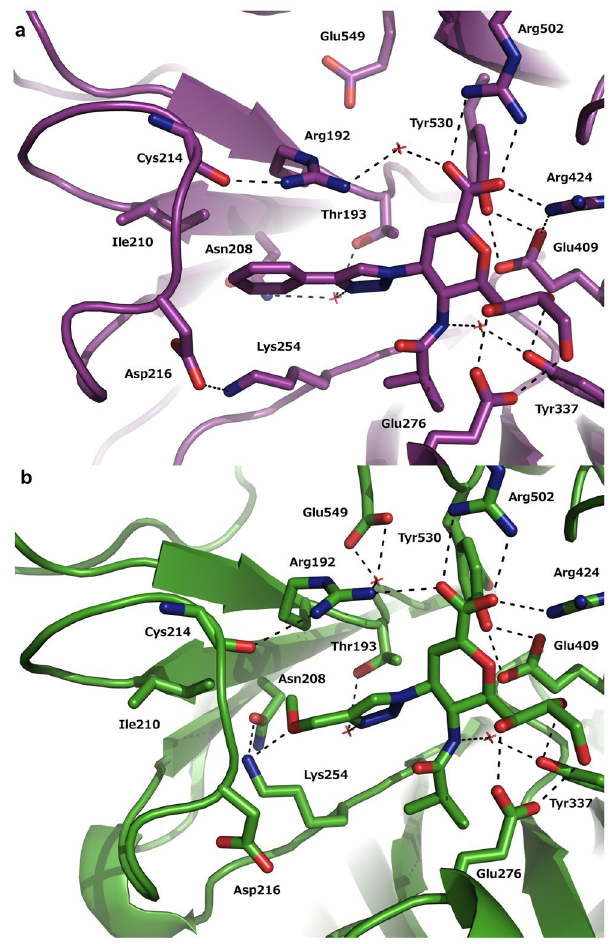
Figure 3. hPIV-3 HN– 5 and – 6 complexes. hPIV-3 HN active site complexed with inhibitor 5 (top) and with inhibitor 6 (bottom) displaying amino acids that are engaged in the binding event as well as three active site resident water molecules. Potential hydrogen bonds are shown as black dotted lines. O red, N